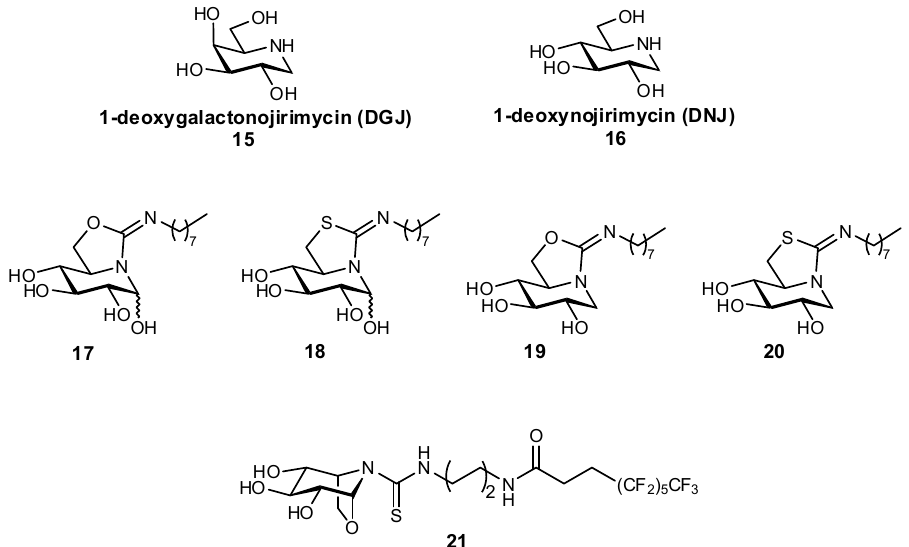
Figure 7. Iminosugars have been used as pharmacological chaperones, in efforts to treat lysosomal storage diseases [63,66] .